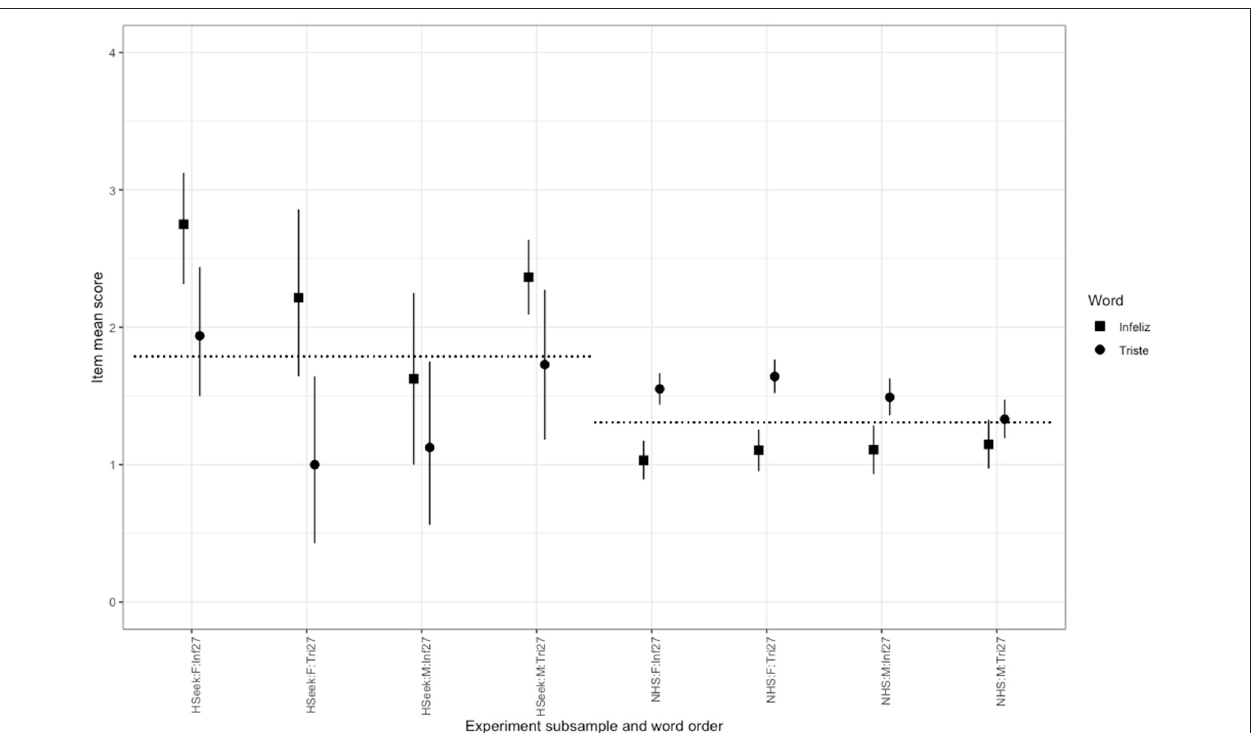
detect probable population differences and to give some precision of estimation of the quantitative differences between the two words. This substudy confirmed that the differences were small but not trivial and might impact on scores using the